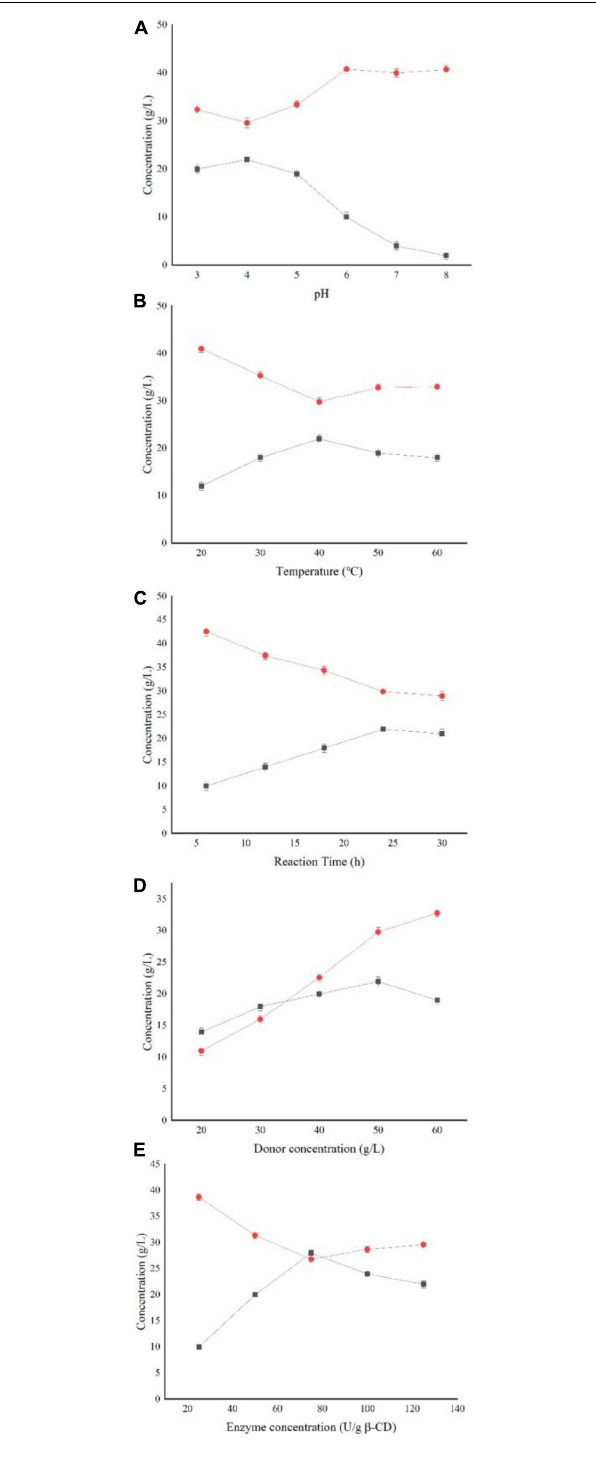
FIGURE 6 | Effect of reaction conditions on AA-2G synthesis. (A) Influence of pH on AA-2G synthesis, (B) influence of temperature on AA-2G synthesis, (C) influence of reaction time on AA-2G synthesis, (D) influence of donor concentration on AA-2G synthesis, and (E) influence of enzyme concentration on AA-2G synthesis. AA-2G production ( filled squares ), L -AA residual content ( filled circles ).